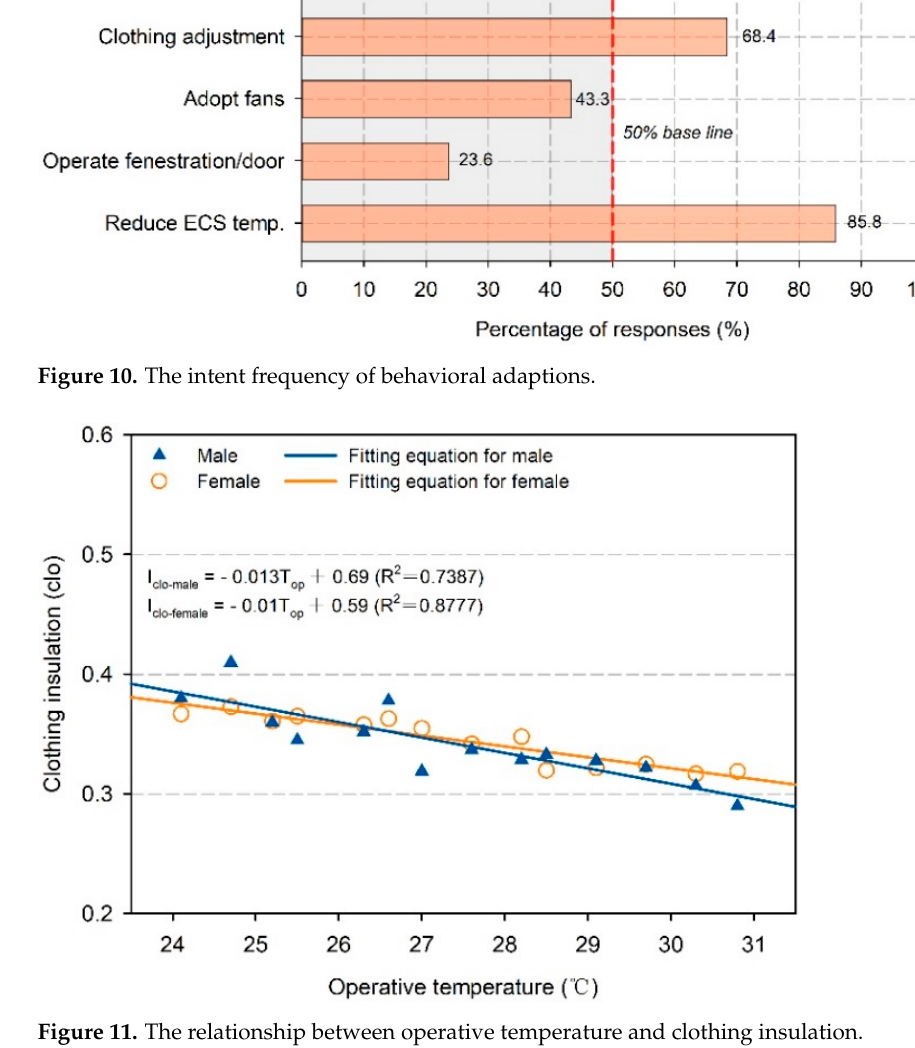
Figure 10. The intent frequency of behavioral